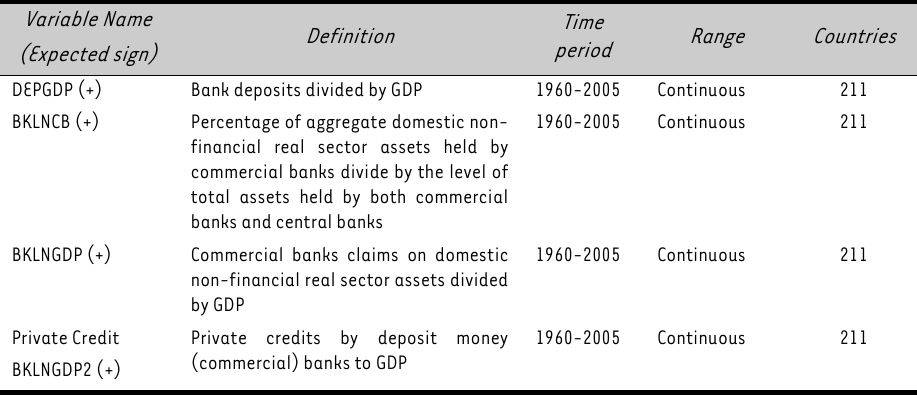
relevant measures for banking sector Alternative measure of 𝑭𝑺𝑫𝟏 𝒊𝒕